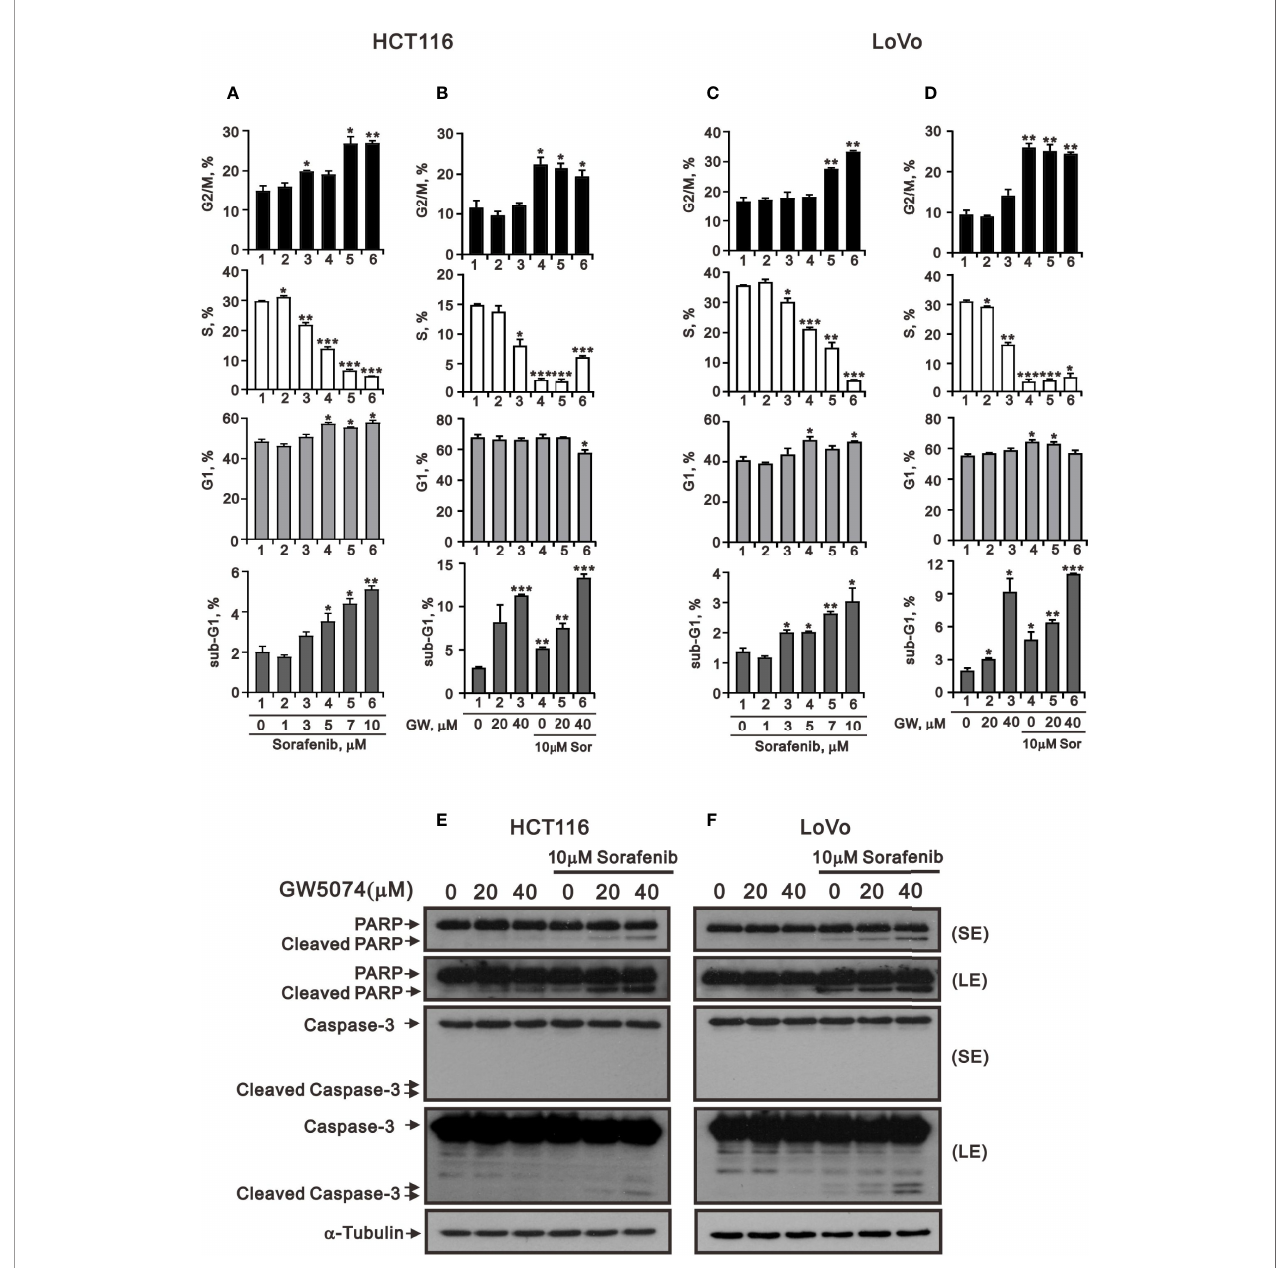
FIGURE 3 | The effects of GW5074 and sorafenib on the cell cycle pro fi le of HCT116 and LoVo cells. HCT116 (A) and LoVo (C) cells were treated with 0, 1, 3, 5, 7, and 10 µM sorafenib for 24 h. HCT116 (B) and LoVo (D) cells were treated for 24 h with 0, 20, and 40 µM GW5074 in the absence or presence of 10 µM sorafenib. (E, F) Western blot analysis was applied for the cleavage off PARP and Caspase 3 proteins. a -tubulin is a loading control protein. SE: shorter exposure; LE: longer exposure. The results (A – D) are representative of three independent experiments. * p < 0.05, ** p < 0.01, and *** p <